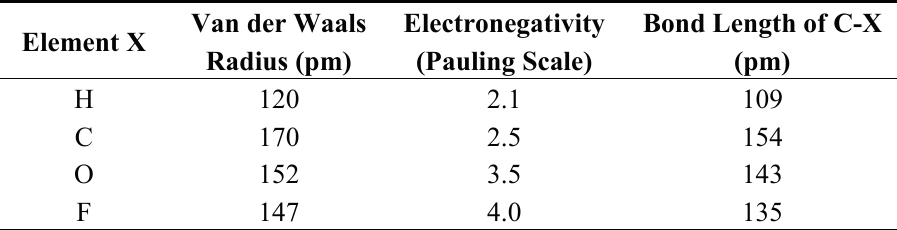
Table 2. Van der Waals radii [13], electronegativity and aliphatic C-X bond lengths of selected